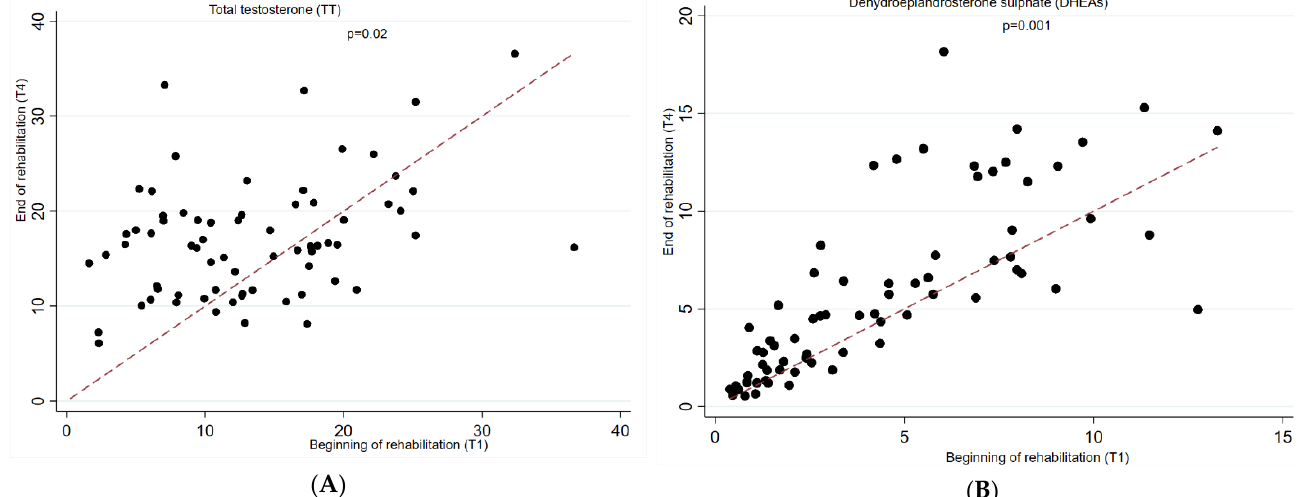
Figure 2. Bivariate plots of changes in androgen sex hormone levels in men with spinal cord injury. The bivariate plot shows individual changes in ( A ) total testosterone and ( B ) DHEA-S comparing the beginning and end of the rehabilitation period. A dotted line represents a line of no change. Every circle represents a person. A circle above the line indicates that a person had a higher level of androgen at follow-up as compared to baseline, whereas a circle below the line indicates that a person had a lower level of androgen at follow-up as compared to baseline.